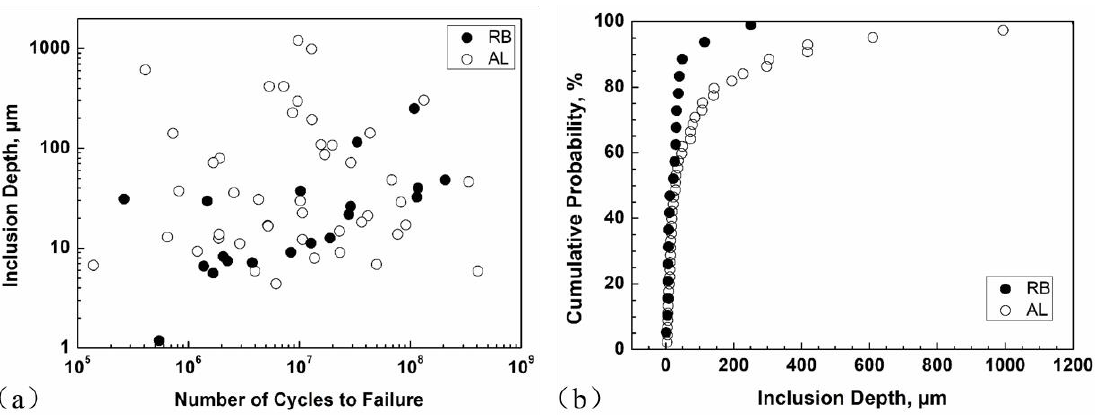
Figure 10. Values of inclusion depths from specimen surface versus fatigue life ( a ) and cumulative probability of inclusion depths ( b ) for RB and AL methods.